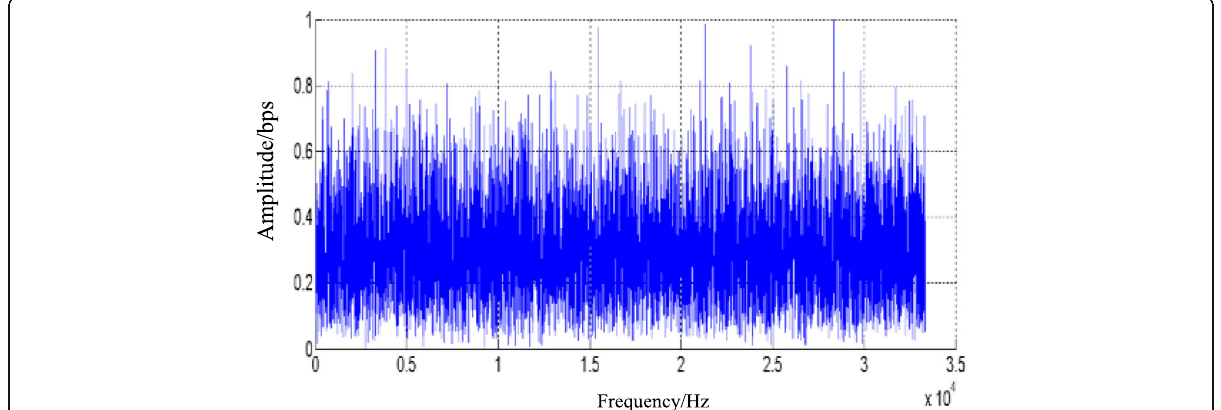
Fig. 7 Time domain waveform of social network protection